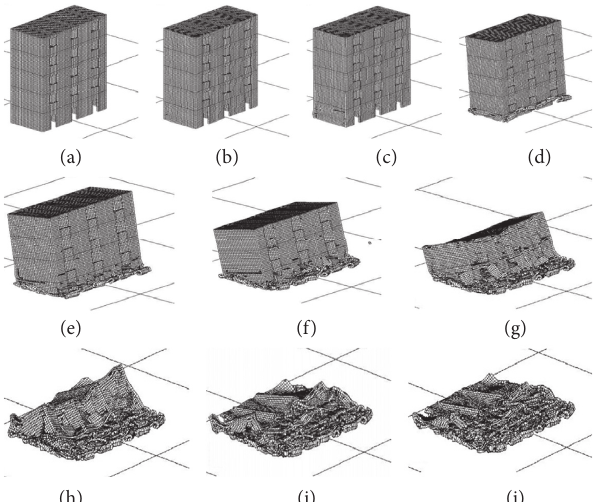
Figure 9: Collapse process of the five-story masonry structure under the 14th working condition. (a) t � 0 s, (b) t � 1.35s, (c) t � 2.00s, (d) t � 2.74s, (e) t � 3.16s, (f) t � 3.56s (g) t � 3.93s, (h) t � 4.23s, (i) t � 4.60s, and (j) t � 10s.